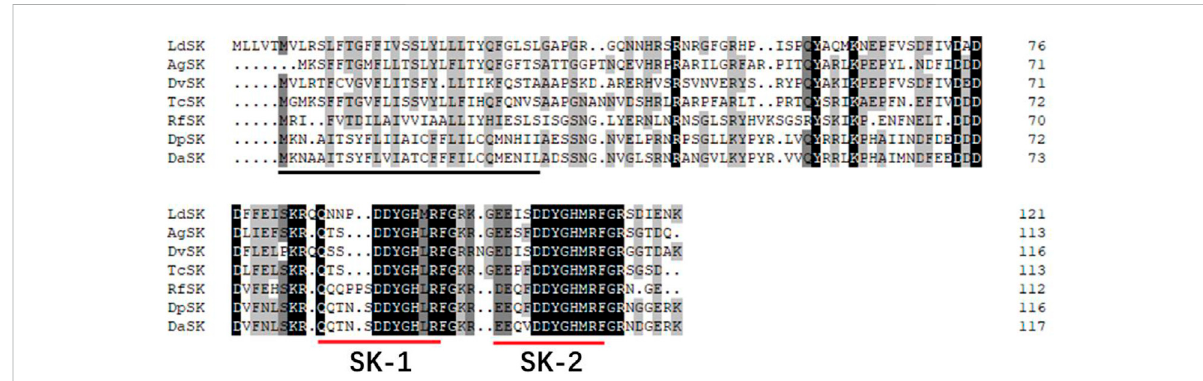
FIGURE 1 Deduced amino acid sequence of D. armandi SK and comparison of the amino acid sequence of the SKs with those of other species. They include Dendroctonus ponderosae (DpSK), Rhynchophorus ferrugineus (RfSK), Tribolium castaneum (TcSK), Diabrotica virgifera virgifera (DvSK), Anoplophora glabripennis (AgSK), and Leptinotarsa decemlineata (LdSK). The putative signal region is indicated by a solid black line, and the regions corresponding to two SKs are underlined by a solid red line. Identical amino acid residues in all proteins are shown in black, and grey parts indicate similar amino acids.